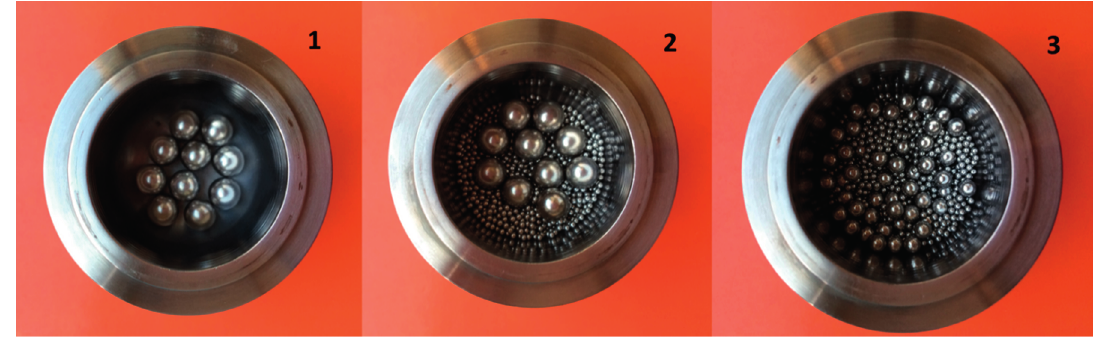
Figure 1. Jar and balls (Entries 1–3 Table 1).